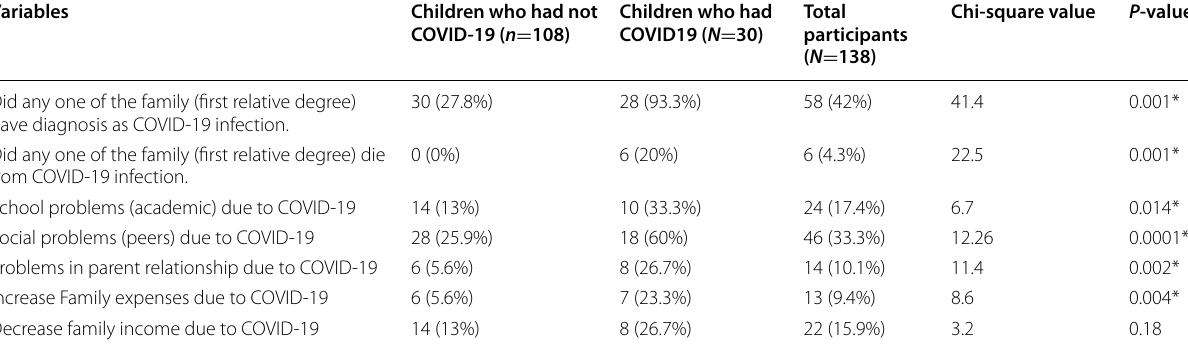
*Significant p value